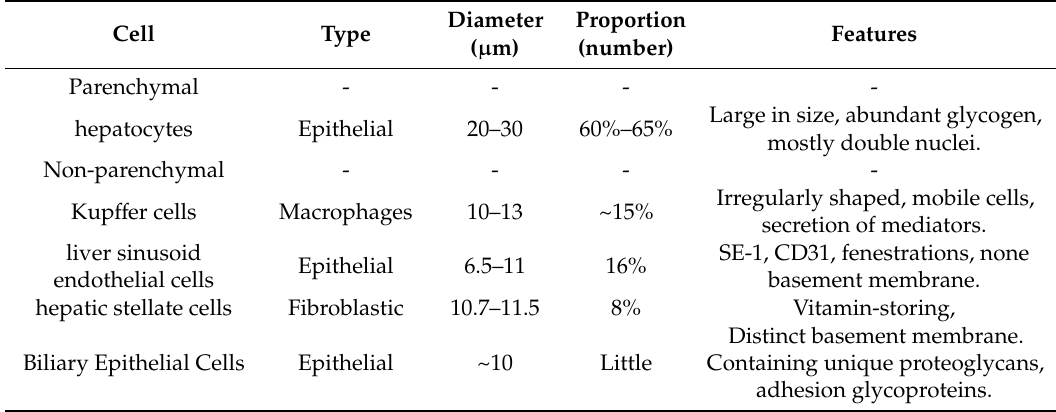
Table 1. Main cell types of the liver and their